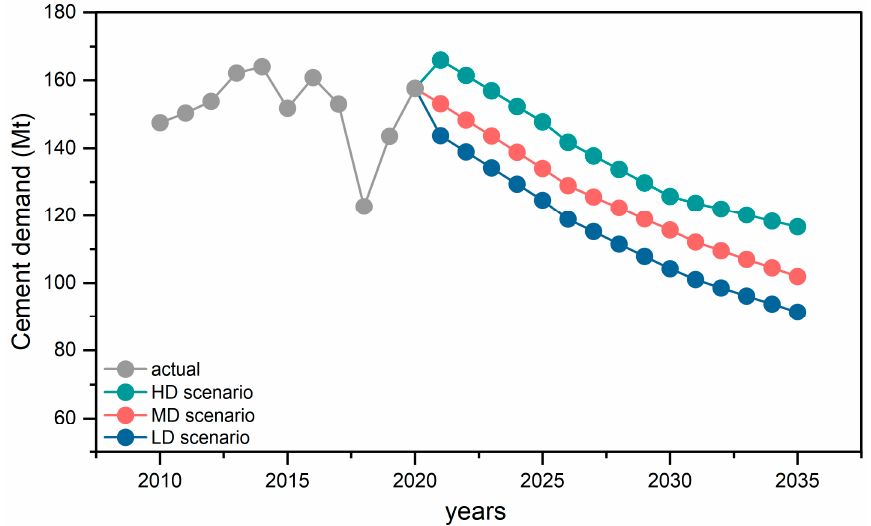
Figure 1. Cement demand in Shandong Province under different scenarios from 2020 to 2035.